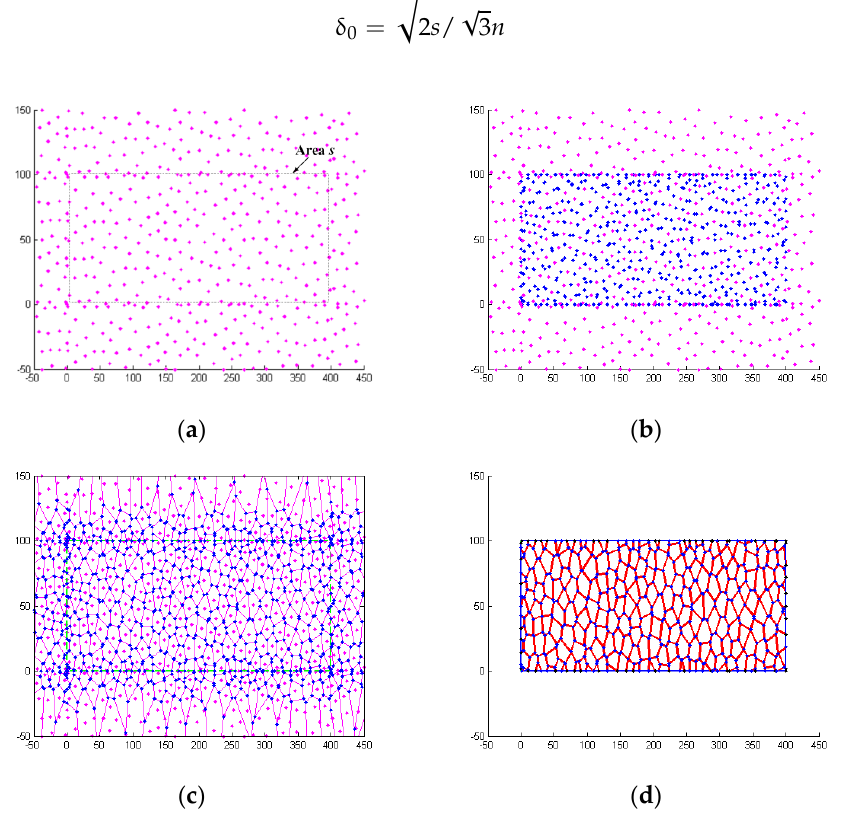
Figure 6. Four main stages of the Voronoi technique: ( a ) Nuclei in given space s ; ( b ) Delaunay triangulation and Voronoi diagram; ( c ) Voronoi structure.